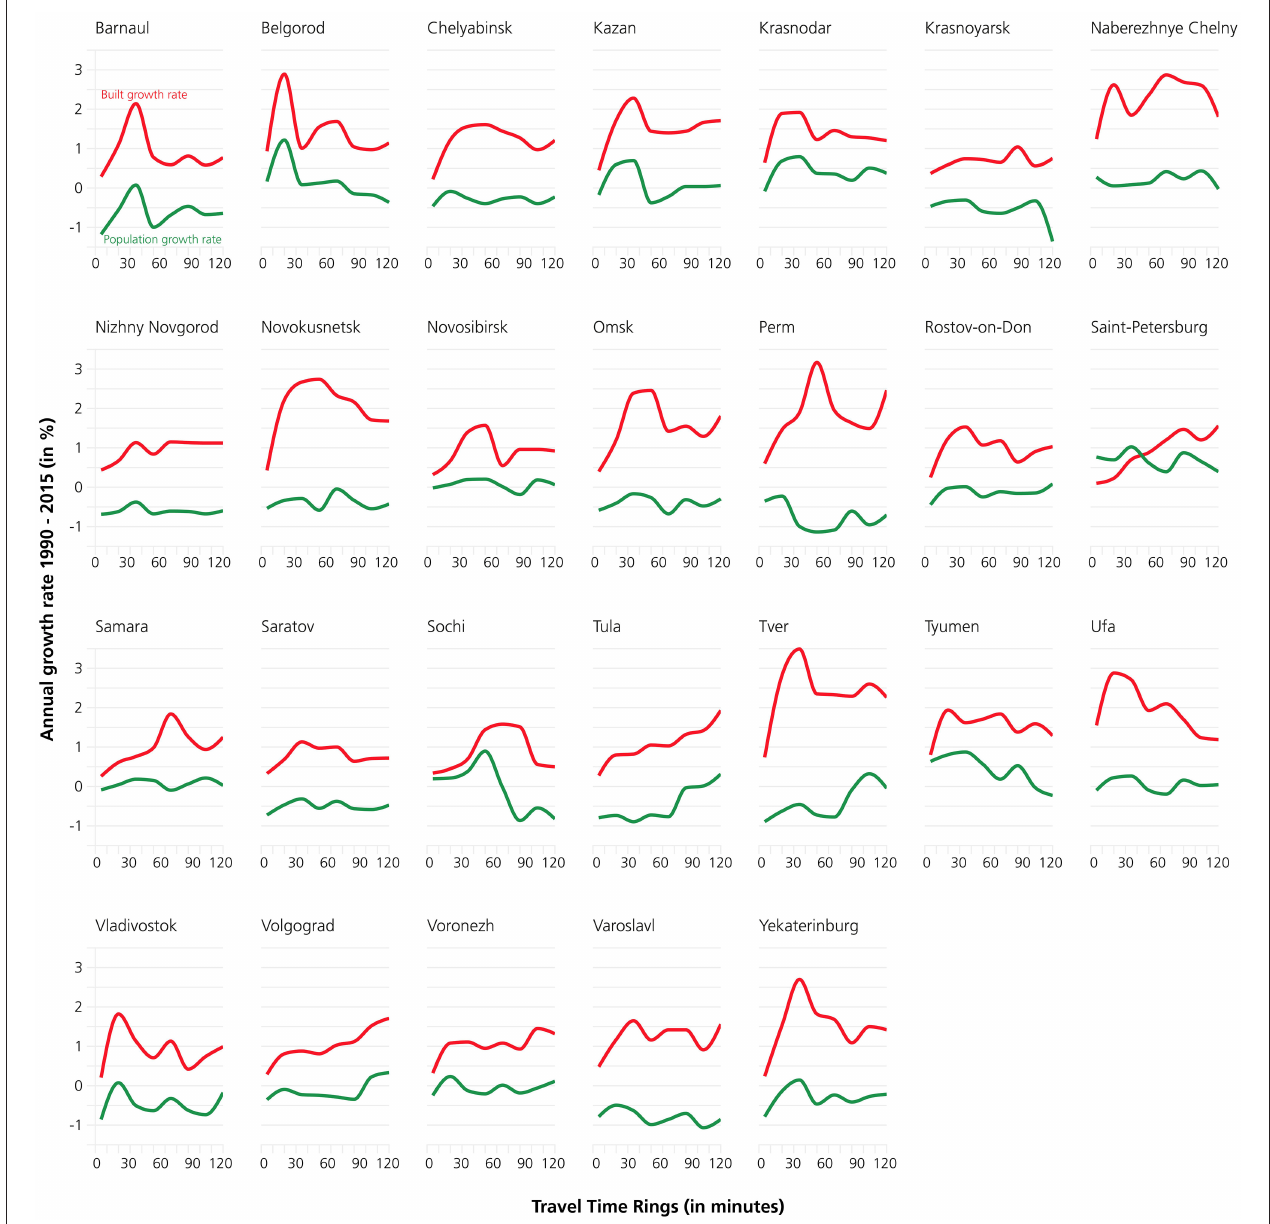
FIGURE 4 | Built-up and population growth rates for selected city regions in Russia (Graphic: C.